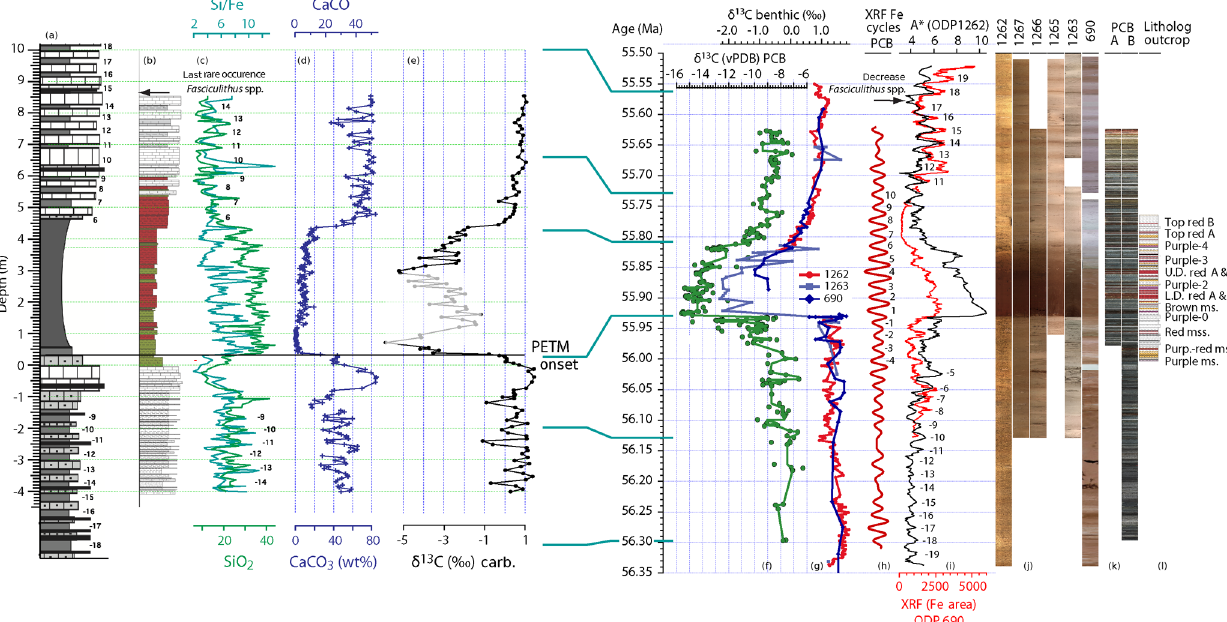
Figure 2. New sediment geochemistry data for the Zumaia section and correlation to existing deep-ocean and terrestrial records (inter-site correlations and age model of Westerhold et al. 2018). Panels (a) to (e) show data against depth in the Zumaia section: (a) lithological log after Storme et al. (2012); (b) lithological log produced during sample collection for this study (2011); (c) SiO 2 weight percent (green) and Si / Fe ratio (cyan) based on weight percentages of oxides (SiO 2 / Fe 2 O 3 ) from bulk sediment XRF analyses; pre-PETM and post-PETM precession cycles numbered in black; (d) weight percentage of CaO and CaCO 3 from XRF; (e) new bulk carbonate δ 13 C (this study). Panels (f) to (l) show data against age (Westerhold et al., 2018): (f) Polecat Bench core (PCB) soil carbonate nodule δ 13 C (green; Bown et al. 2015); (g) deep-ocean benthic foraminiferal δ 13 C (Bains et al., 1999; McCarren et al., 2008); (h) Gaussian filter of the longer 8.2m cycle (precession) of the Fe data from PCB-B (red; Westerhold et al., 2018); (i) ODP Site 690 XRF core scanning Fe data (red) and ODP Site 1262 A* colour reflectance data (black); (j) composite core section photos from deep-ocean sites ODP 1262, 1267, 1266, 1265, 1263 and 690; (k) terrestrial PCB sites A and B, with the latter correlated to (l) nearby outcrop lithologies (Westerhold et al.,